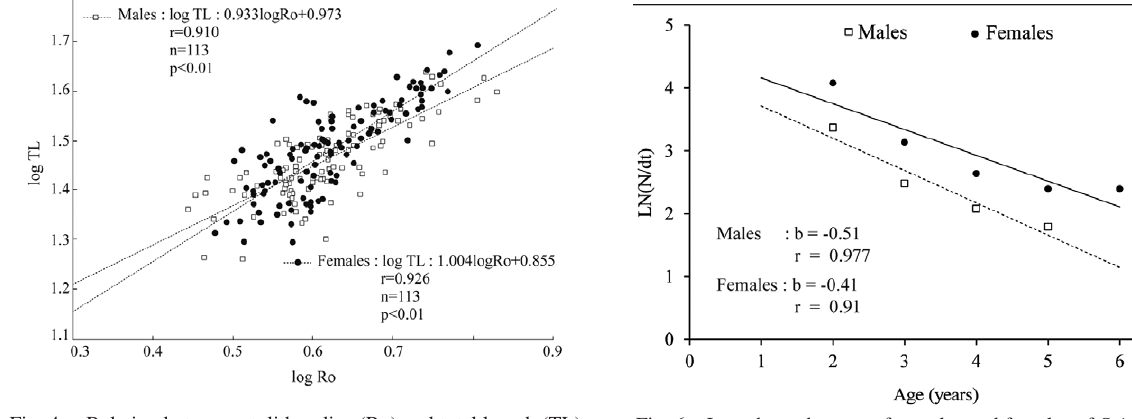
Fig. 6 – Length catch curves for males and females of Sciaena um- bra in the Gulf of